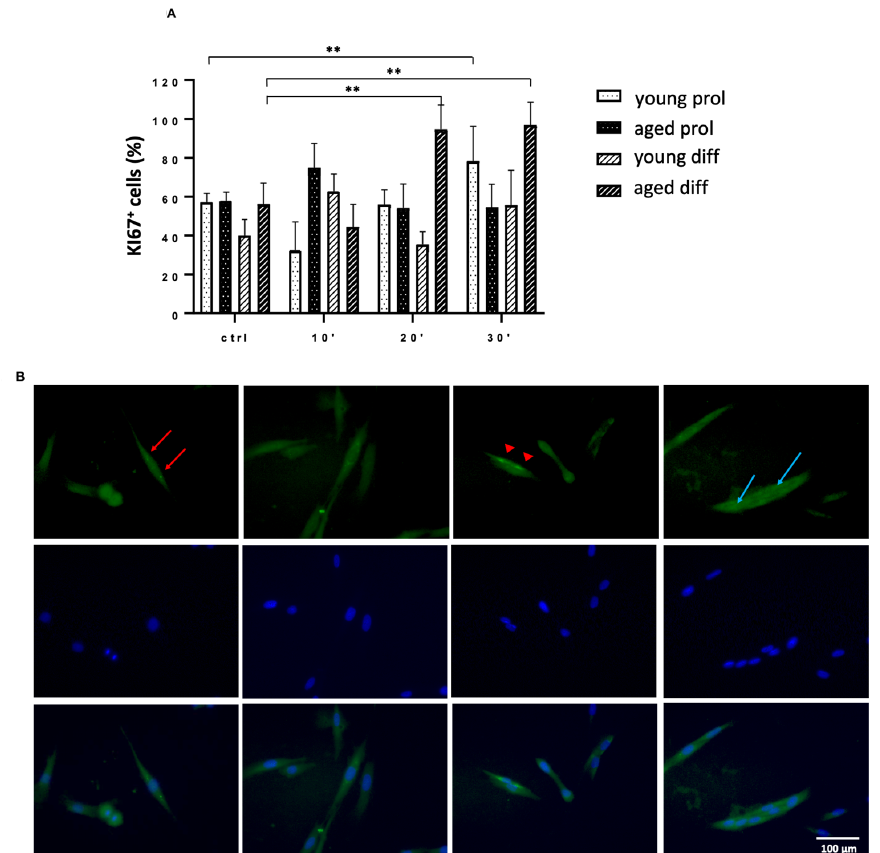
Figure 9. Effect of ViSS treatment on SC activation. ( A ) Data are expressed as percentage ± SEM of three independent experiments ( n = 3) in comparison with age-matched controls. Ki67-positive cells were scored out of a total of 40–80 cells for each experimental group. Significance was determined with two-way ANOVA test, followed by Tukey’s multiple comparison test (main row effect). ** p ≤ 0.005. ( B ) Representative patterns of localization of green-fluorescent Ki67 labeling at perinuclear level (red arrows), nuclear level (red arrowheads), and at cytoplasm (pale blue arrows). In merge panels at the bottom, green fluorescence of Ki67 is overlapped with blue fluorescence of nuclear DAPI staining.